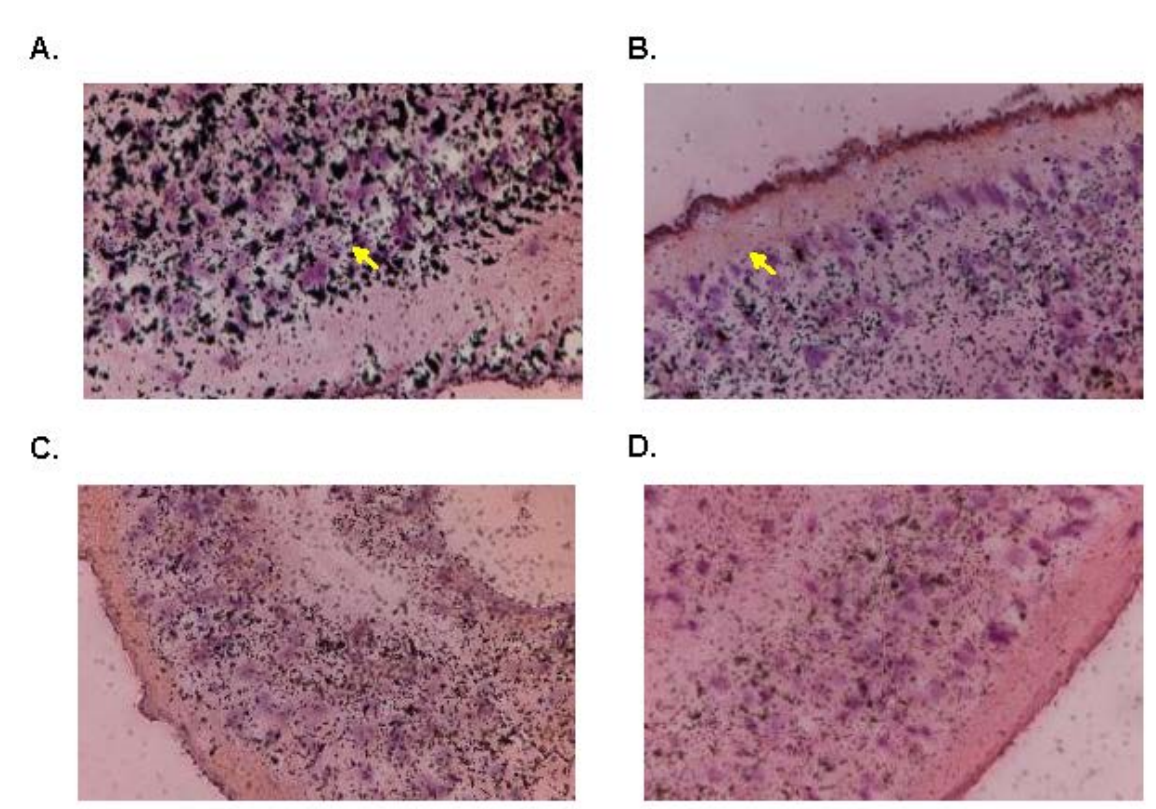
Figure 12. Silver Grain Placement in Radiolabeled-OXA Treated Worms. Silver grains in H&Estained parasite sections. Yellow arrows indicate prominent clusters of silver grains. The clustering is less prominent the longer the worm is exposed to OXA. ( A ) Day 2, ( B ) Day 4, ( C ) Day 6, ( D ) Day 12.